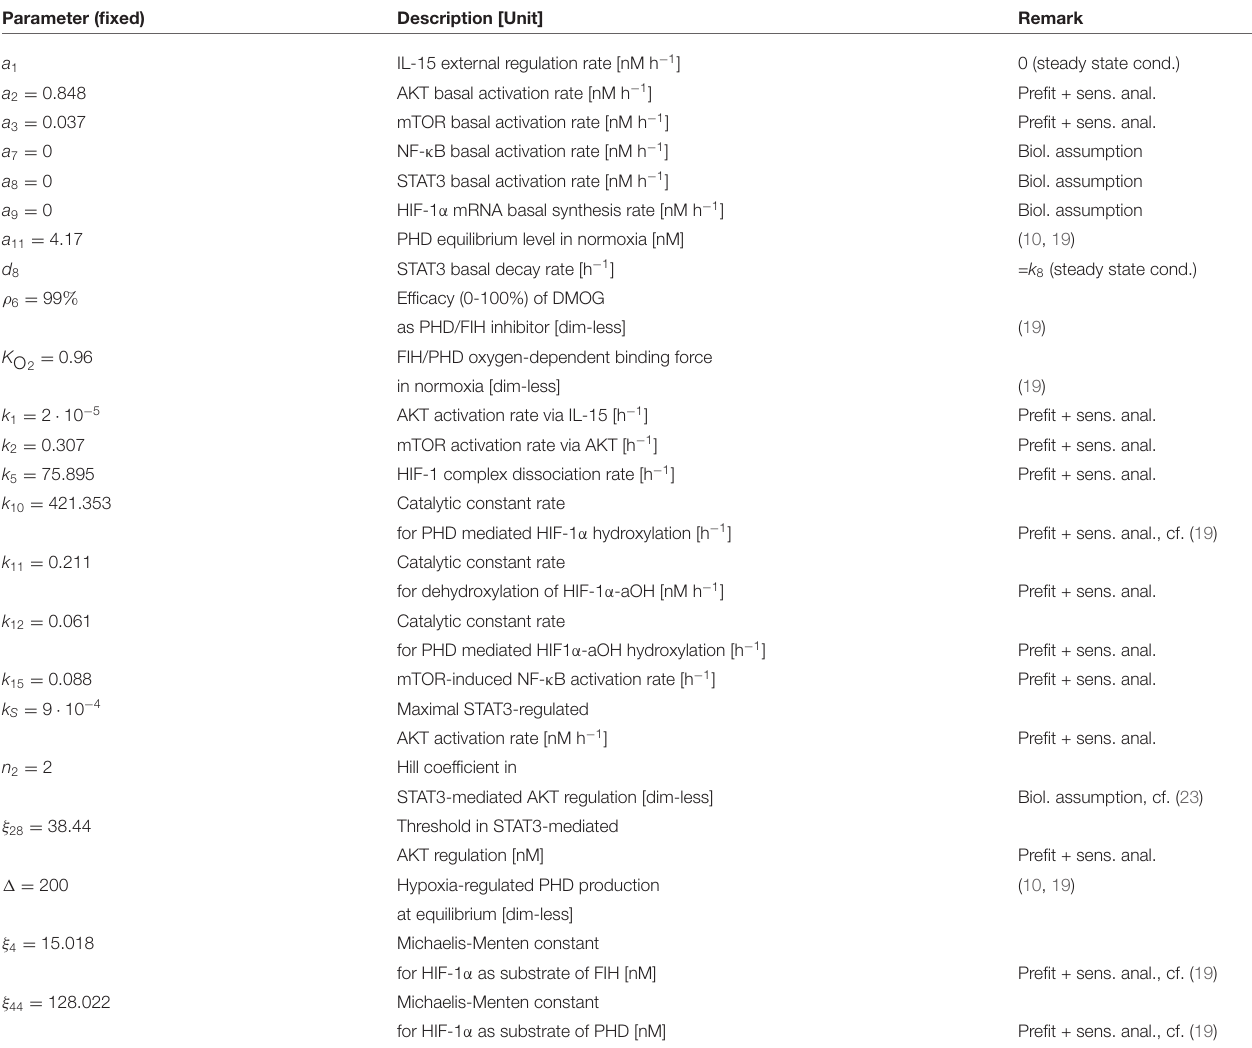
TABLE 1 | Parameter description and values used for the mathematical model